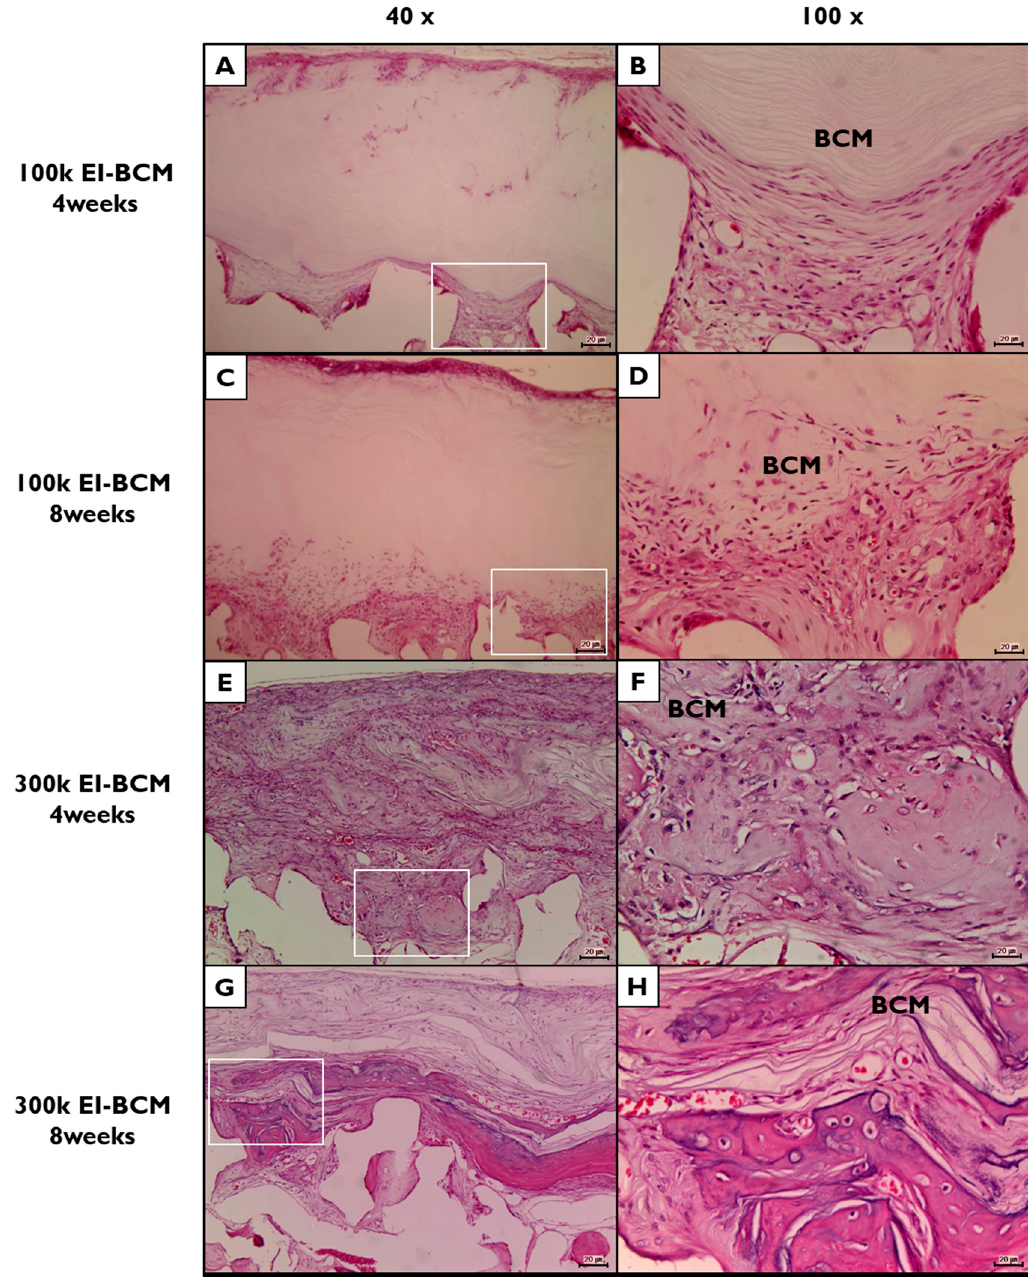
Figure 11. Histological view of electron beam irradiated bacterial cellulose membranes (EI-BCMs) in H&E stained defect sites. ( A , B ) 100k EI-BCM group at 4 weeks after surgery; ( C , D ) 100k EI-BCM group at 8 weeks; ( E , F ) 300k EI-BCM group at 4 weeks; ( G , H ) 300k EI-BCM group at 8 weeks; BCM , bacterial cellulose membrane. (Original magnifications: ( A , C , E , G ) 40×; ( B , D , F , H ) 100×).